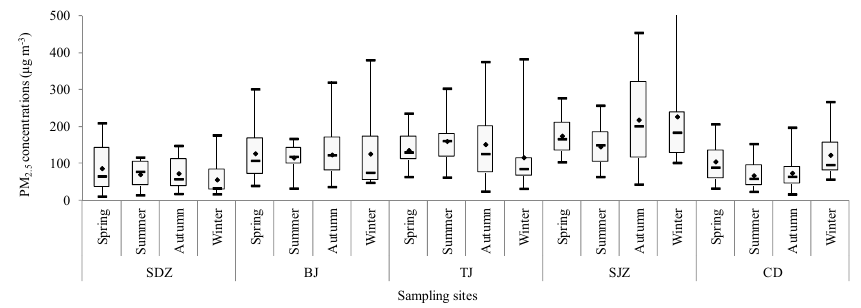
Figure 4. Seasonal PM 2.5 concentrations at five sites. The boxes and whiskers denote Fig. 4. Seasonal PM 2 . 5 concentrations at the five sites. The boxes and whiskers denote the minimums, 25 percentiles, medians, 75 percentiles, and maximums; the dots denote the mean values. * Max. for winter at SJZ was 759.6µgm − 3 the minimums, 25 percentiles, medians, 75 percentiles, and maximums, the dots denote the mean values. *Max. for winter at SJZ was 759.6 μ g m -3 .